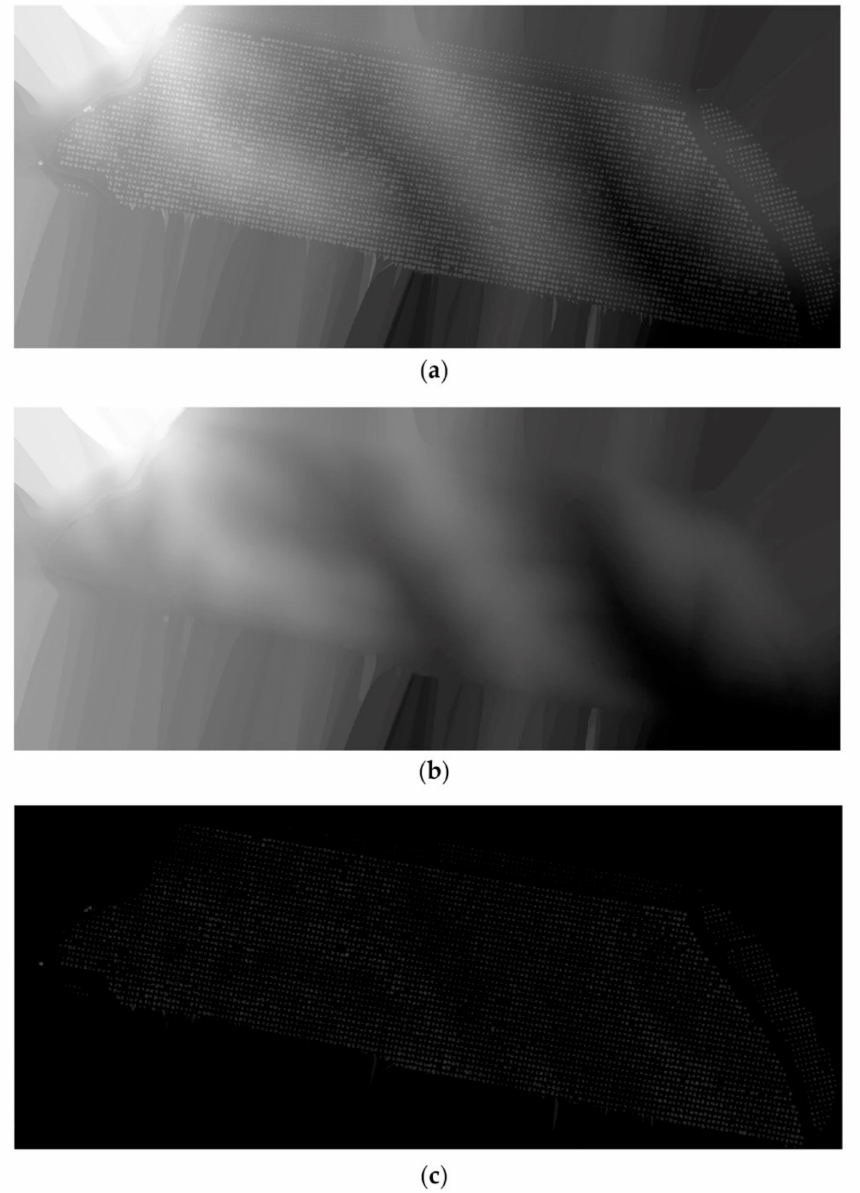
Figure 7. ( a ) Greyscale image I GS 1 resulting from filling gaps in the image shown in Figure 5, GS DMS ; ( b ) background estimation of ( a ), I BE ; ( c ) resulting image I GS 2 after subtracting ( b ) to ( a DEF